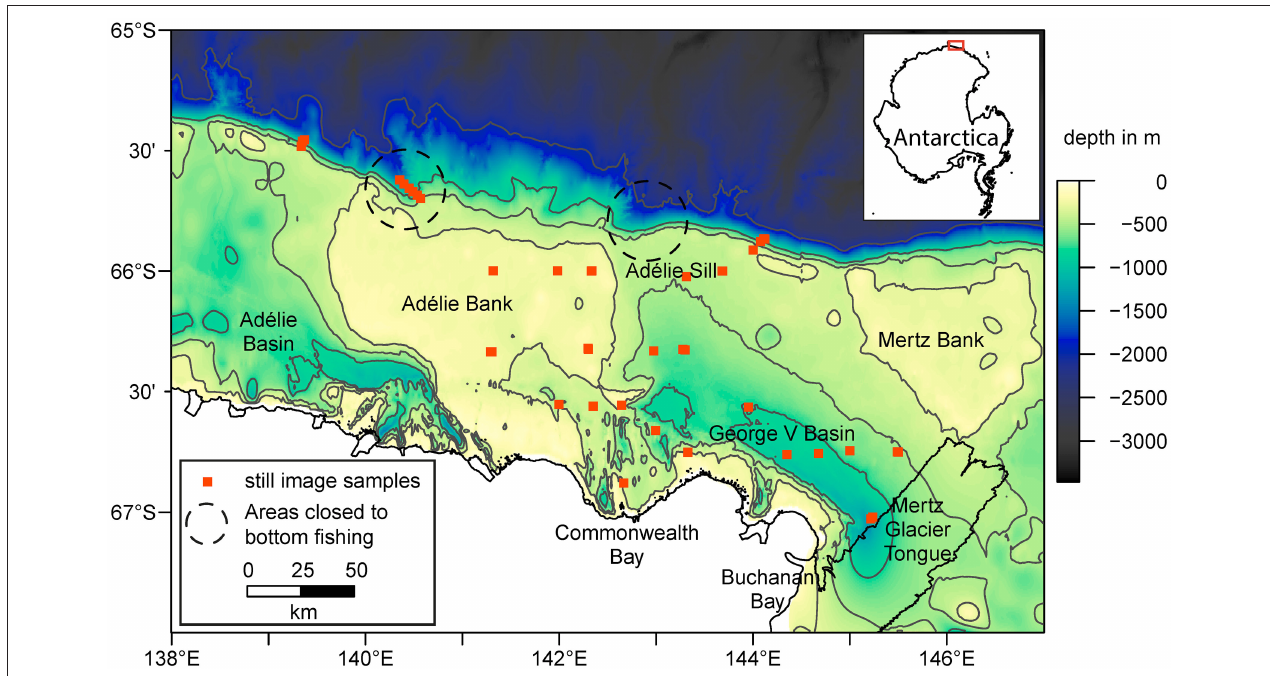
FIGURE 1 | Overview of the George V shelf, East Antarctica. Shown are the bathymetry (Beaman et al., 2011) with selected contour lines (in gray), coastline, sample locations, and approximate location of areas closed to bottom fishing due to the presence of vulnerable marine ecosystems (Jones, 2017). The inset map in the top right corner shows the location of the study area as highlighted by the red